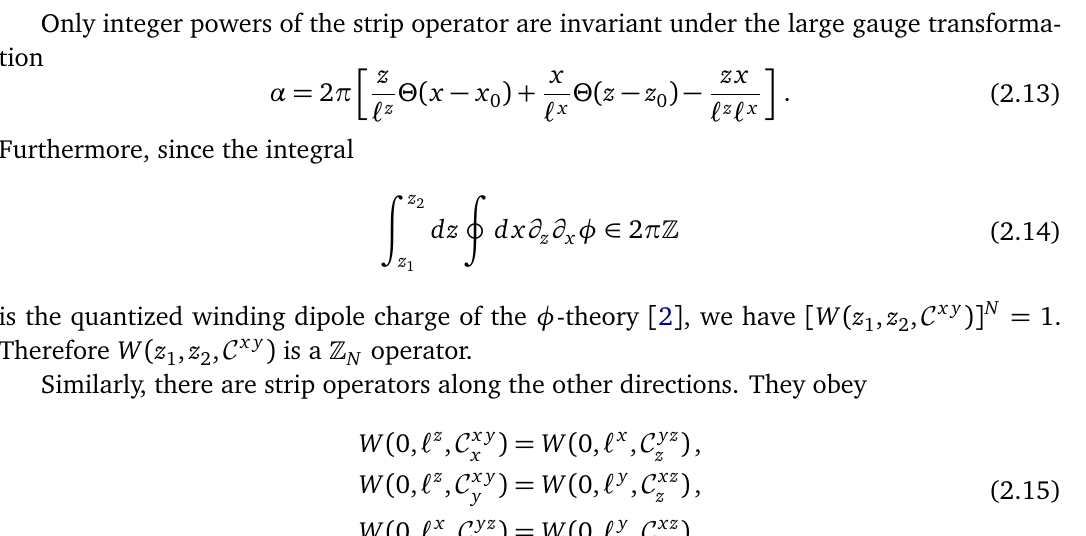
Figure 3: The global symmetries of the U ( 1 ) A -theory, the φ -theory, and the (cid:90) gauge theory and their relations. The momentum dipole symmetry of the φ -theory is gauged and therefore it is absent in the (cid:90) tensor symmetry of the A -theory is absent in the (cid:90) the constraint